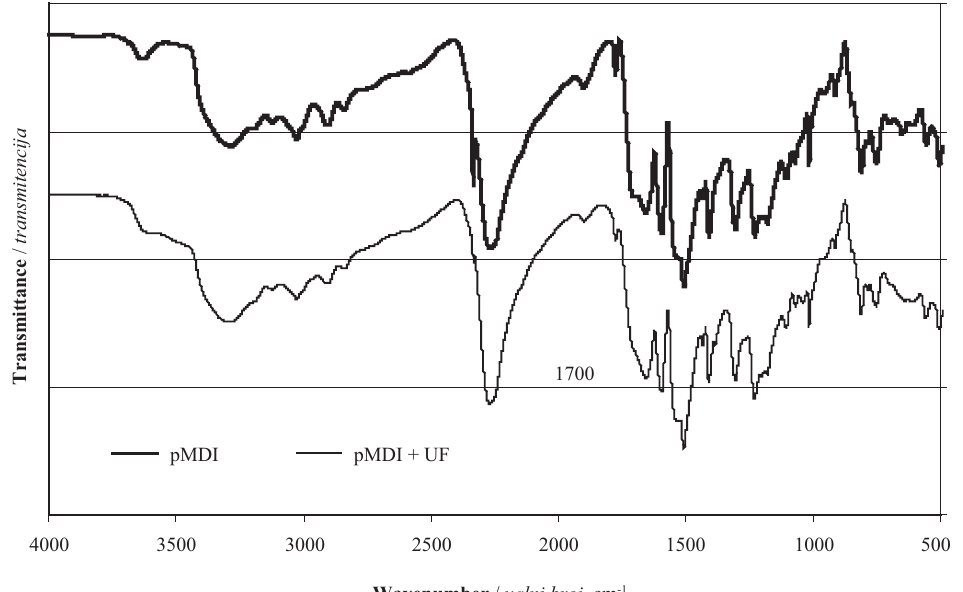
Figure 2 IR spectra of UF resin modifi ed with pMDI